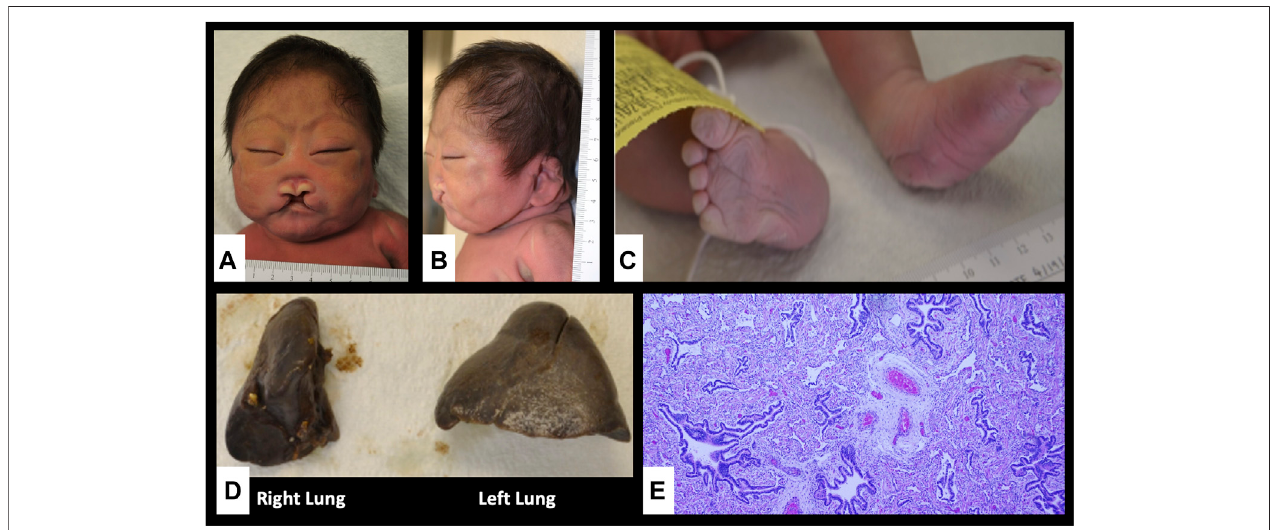
FIGURE 1 | Autopsy fi ndings showing craniofacial dysmorphism, limb abnormalities and lung hypoplasia. (A,B) Flat face, low anterior and posterior hairlines, synophrys, hypotelorism, upslanting palpebral fi ssures, large fl oppy low-set ears, large midline cleft lip and palate, absent nasal septum, large mouth with down-turned corners and micrognathia; (C) Rocker bottom feet and right talipes equinovalgus; (D) Unilobular right lung; (E) pulmonary hypoplasia and congenital pulmonary airway malformation, type II in the right lung (Hematoxylin and Eosin stain,